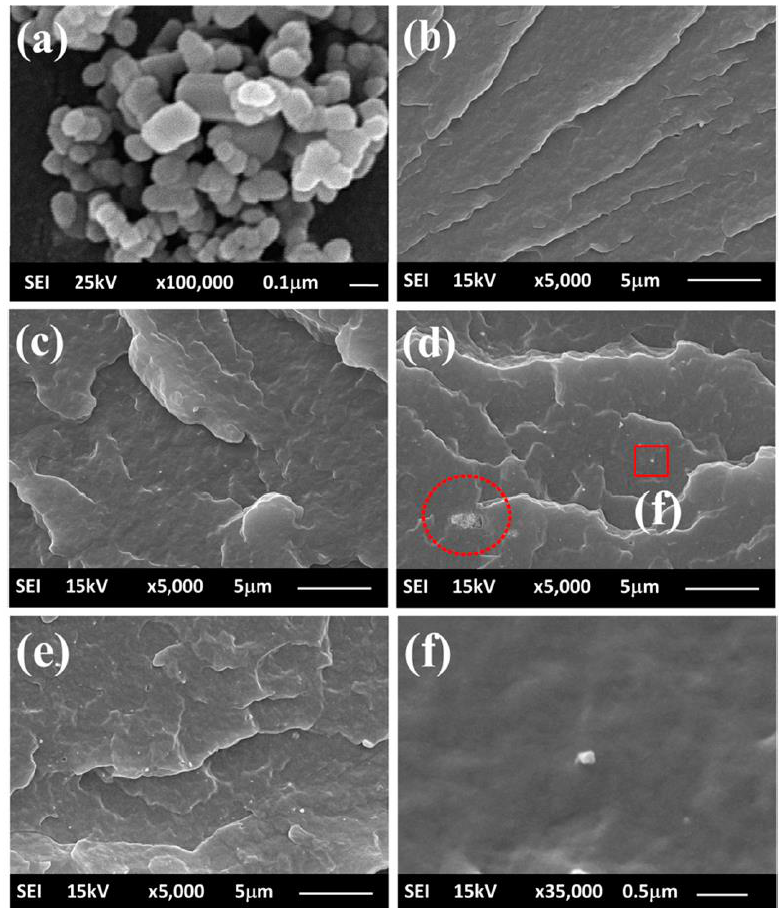
Figure 5. SEM images of the ( a ) neat ZnO nanoparticles and ( b – e ) represent the PP/ZnO nanocom- posites whereas ( f ) inset of ( d ). Reprinted from [48]. The photocatalytic activity test was conducted through the degradation of methylene blue (MB) in UV irradiation [48]. PP containing 0.5% and 1% ZnO displayed MB degra- dation ranging in between 15 and 20% within 5 h, whereas the inclusion of 2% led to 59% degradation within 5 h. This is because of the limited number of ZnO exposed on the surface of PP, viz . at higher ZnO content, more of these fillers protrude on the surface of the host polymer and hence higher MB degradation is achieved (Figure 6). The photostability and reusability of the composites for MB degradation were carried out three times. It was noticed that the nanocomposites maintained a MB degradation efficiency of ~59% for three cycles. It can be deduced that the use of melt-mixing has to be carefully considered in order to control the number of ZnO particles being exposed to the dyed solution. Therefore, large quantities of ZnO are required to achieve a reasonable degradation efficacy because most of these fillers are embedded within the host polymeric